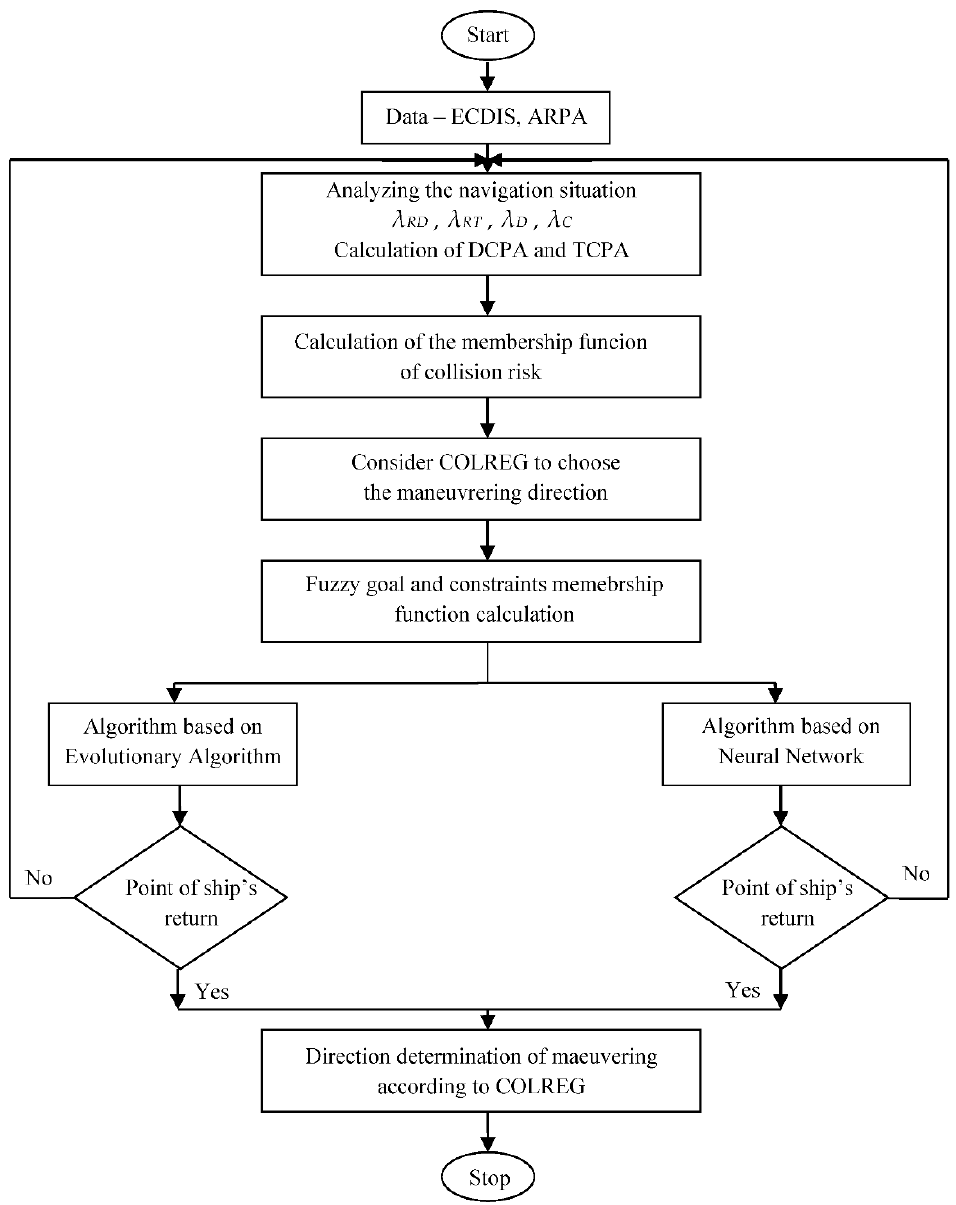
Figure 5. The flowchart of the two algorithms, i.e., ACEA and ACNN, for determining the optimal ship path in a collision situation.